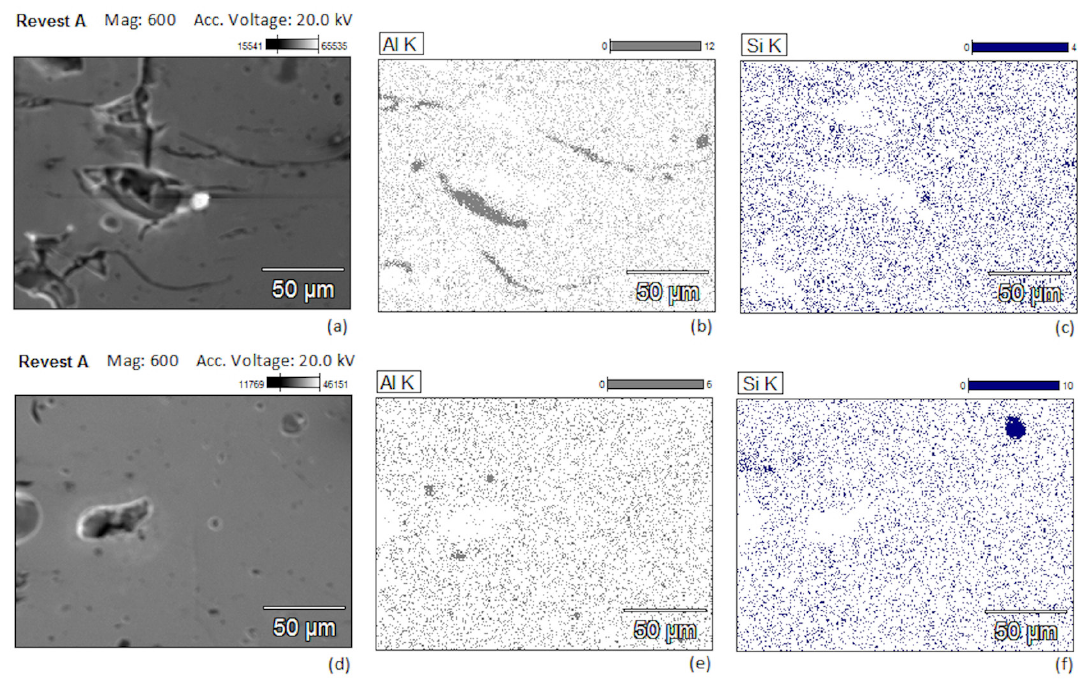
Figure 7. EDS mapping showing the predominant regions of Al and Si where oxides of these elements were probably formed.